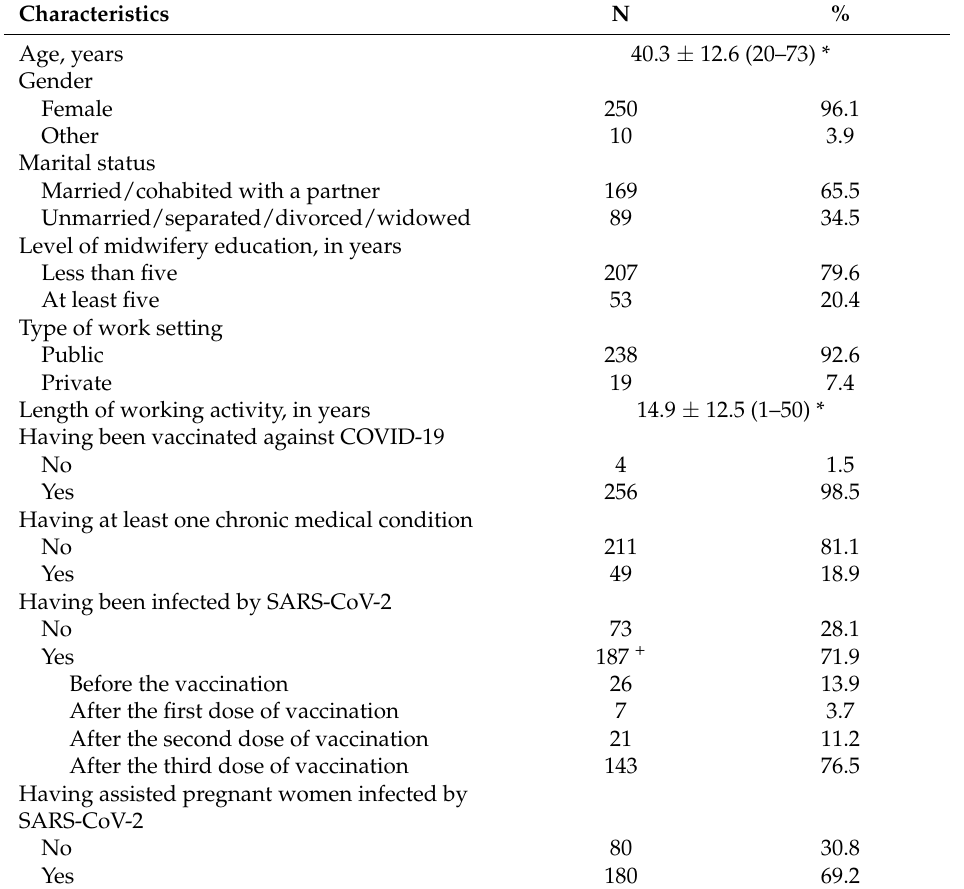
Table 1. Main socio-demographic, professional, and anamnesis characteristics of the sample.